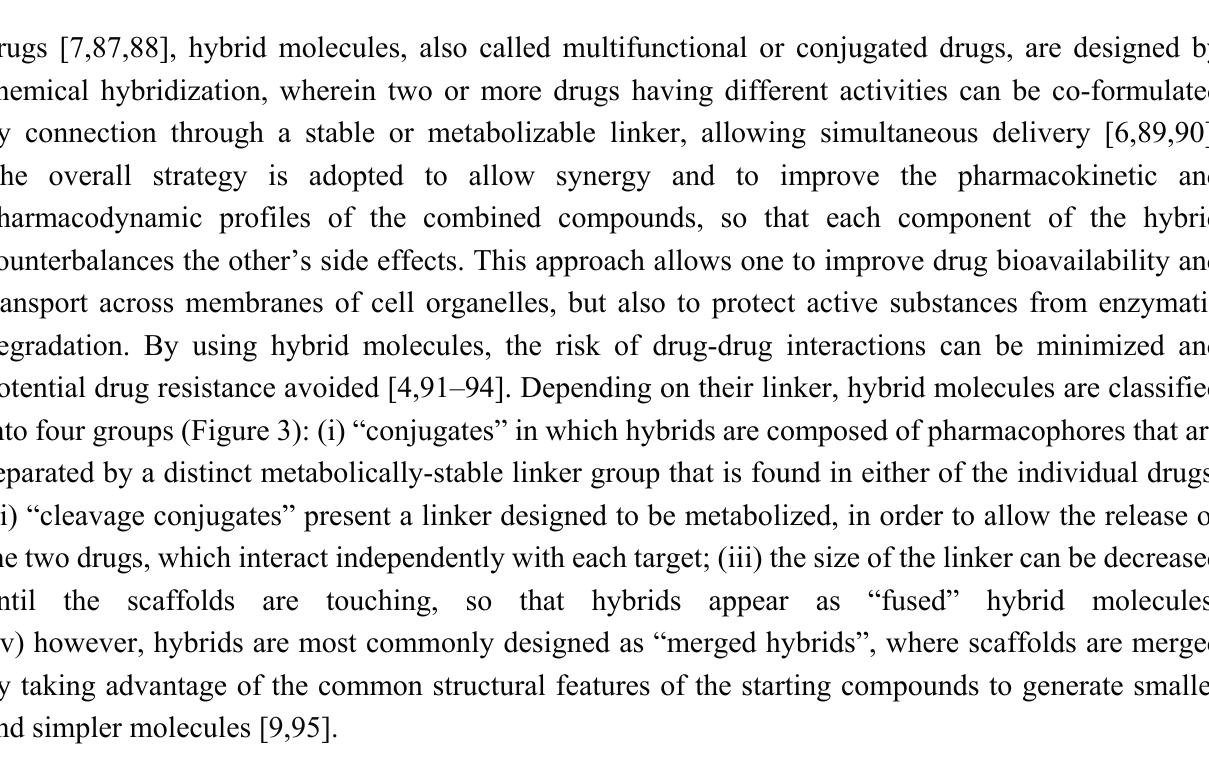
Figure 3. Different approaches for the design of hybrid molecules. The linkers used to connect two pharmacophores can vary and allow defining different types of hybrid molecules: conjugate hybrid, cleavage hybrid, fused hybrid and merged hybrid. (Cu, curcumin; A, molecule; X, common